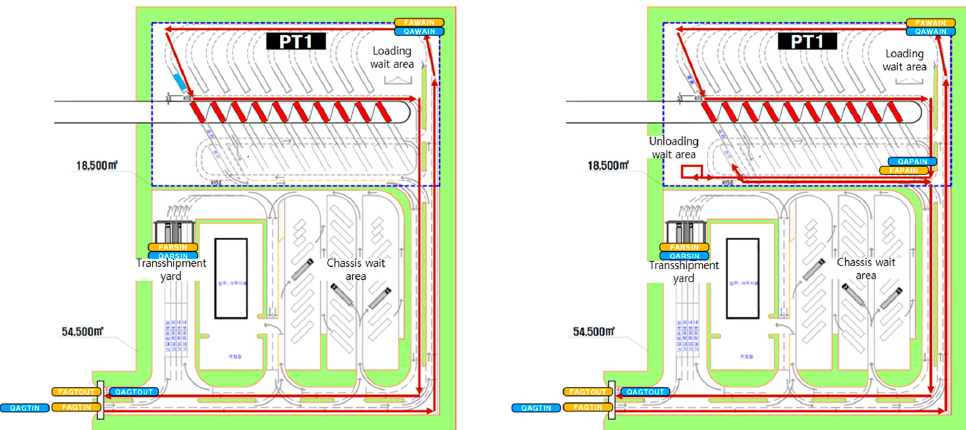
Figure 9. Operation logic for private tractor (left: loading; right: unloading).